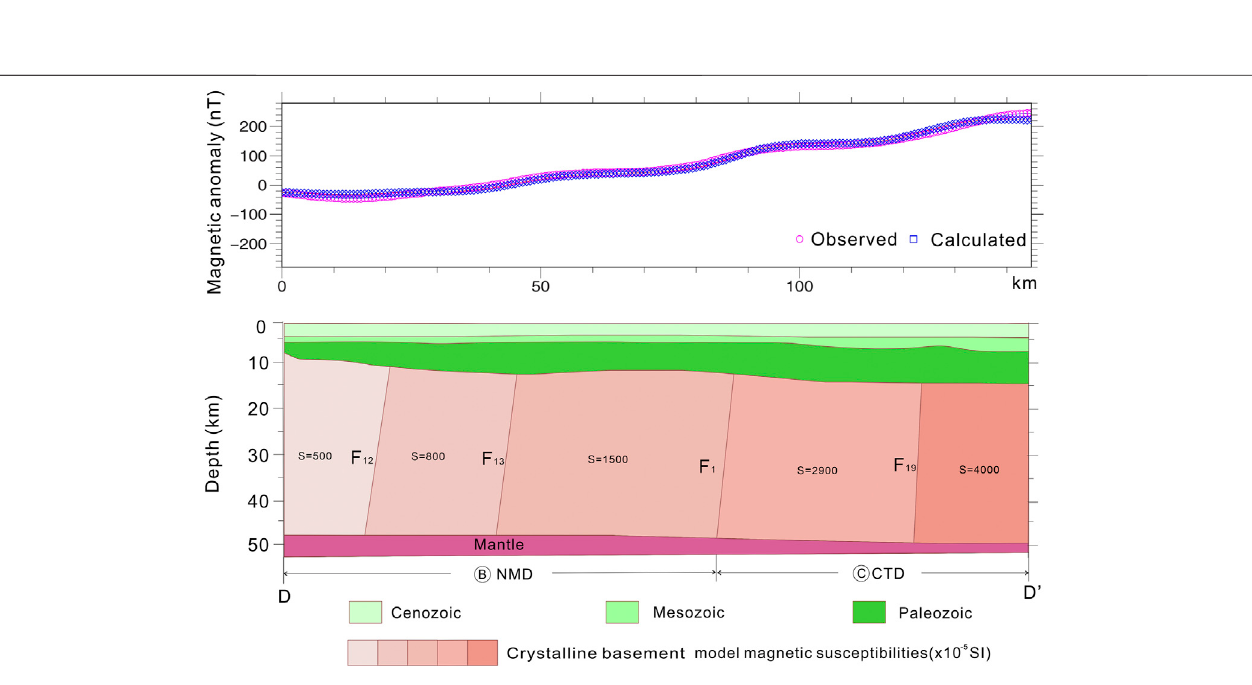
Frontiers in Earth Science |